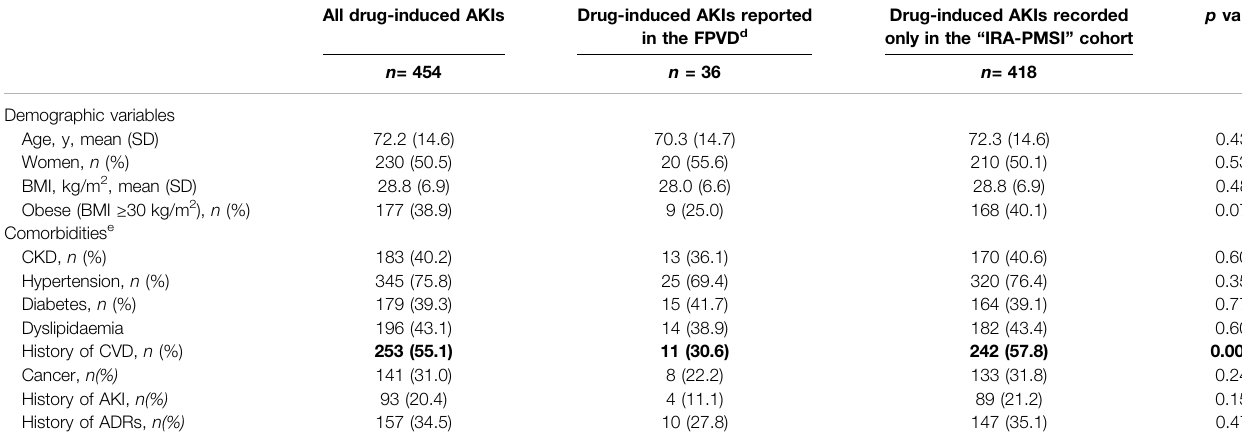
TABLE 1 | Characteristics of the patients with drug-induced AKI, by data source. All drug-induced AKIs Drug-induced AKIs reported Drug-induced AKIs recorded in the FPVD d only in the “ IRA-PMSI ”